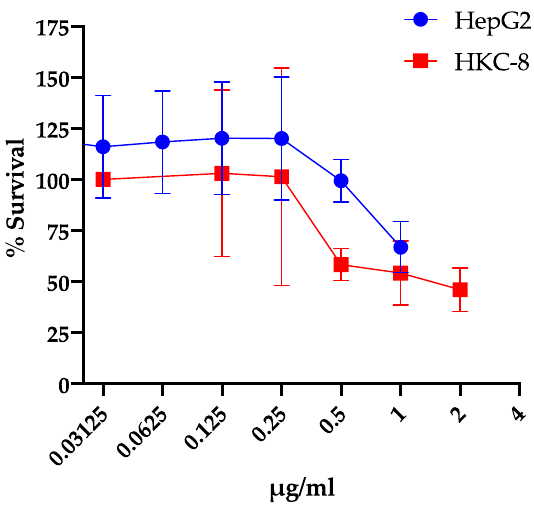
Figure 3. Dose toxicity studies show IMD0354 has cytotoxicity activity above MIC levels. Cytotoxicity testing of human liver cell line HepG2 and human kidney proximal tubular cell line HKC-8 at various concentrations of IMD0354. LC 50 of IMD0354 is 1.1 µg/mL and is 0.94 µg/mL, respectively. Each sample was tested in triplicate. ( n = 3, ± S.D.).